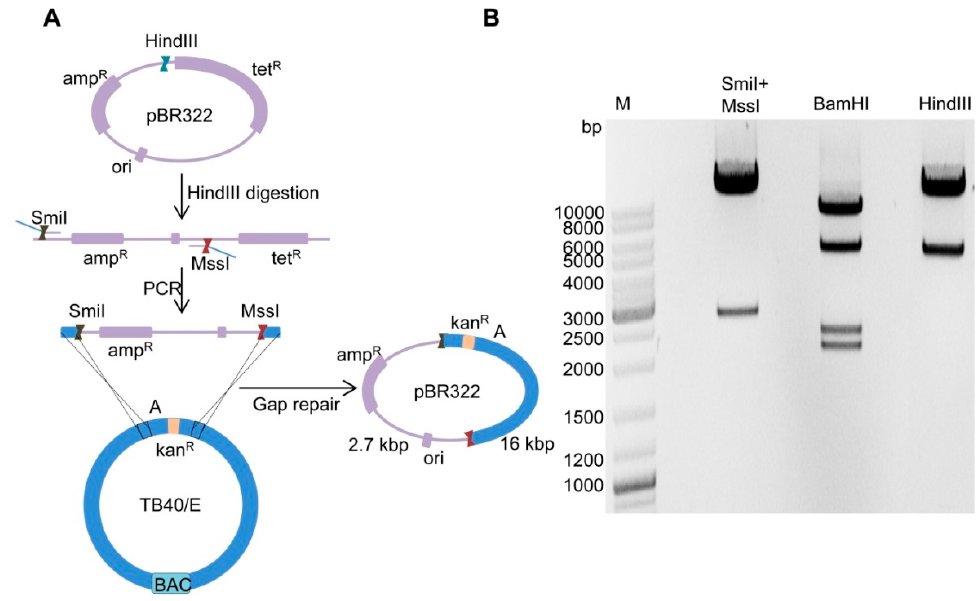
Figure 3. Cloning of the TB40/E ‘A-Ins’ fragment. ( A ) Schematic view of cloning by gap repair. Plasmid pBR322 was linearized by digestion with HindIII and used as template for PCR. Homology arms and restriction sites for SmiI and MssI were included in the primers. The PCR product was purified and electroporated into recombination-competent GS1783 carrying TB40/E-A-Ins3 BAC. Clones were selected with ampicillin and kanamycin. ( B ) Restriction digest of a positive plasmid DNA clone digested with SmiI+MssI, BamHI, and HindIII, respectively.